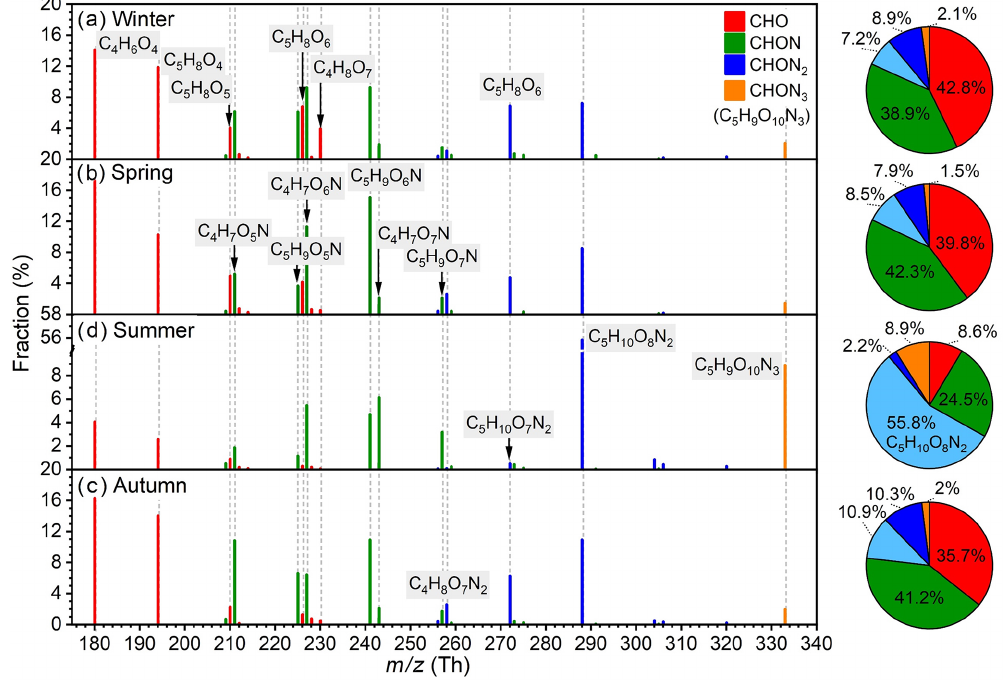
Figure 5. Fractional profiles of each IP OOM molecule in (a) winter, (b) spring, (c) summer, and (d) autumn. The mass-to-charge ratio ( m/z ) denotes OOM clustered with NO − or as deprotonated ones. The fraction of each compound is calculated as the ratio of its concentration to 3 the total concentration of IP OOMs. The red, green, blue, and orange bars are for CHO, CHON, CHON 2 , and CHON 3 OOMs, respectively. Please note that CHON 3 OOMs only include C 5 H 9 O 10 N 3